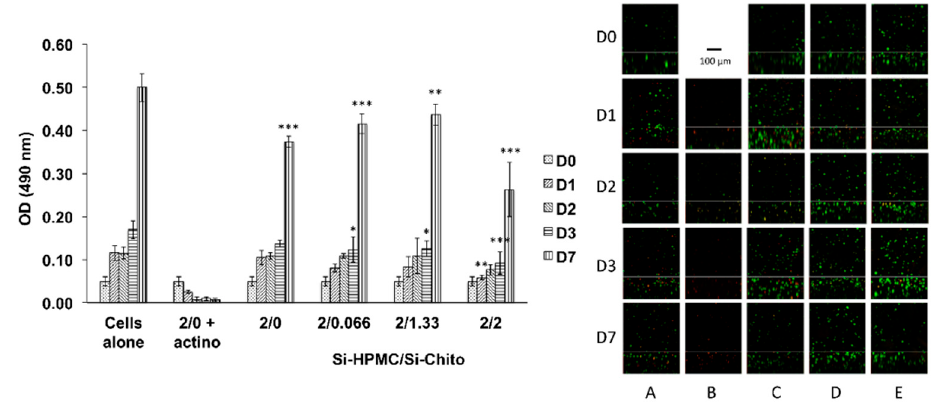
Figure 4. Left: graph representing SW1353 2D cell metabolism (cell growth) with an increasing Si-HPMC concentration over a period of time of 7 days. Right: confocal micrograph representing the 3D cell viability with an increasing Si-chito (Si-HPMC / Si-chito: A: 2% / 0%; B: 2% / 0% + actinomycin; C: 2% / 0.66%; D: 2% / 1.33 and E: 2% / 2%) concentration over a period of time of 7 days (D0, D1, D2, D3 and D7) using LIVE / DEAD staining kit labeling living cells in green and dead cells in red. Si-HPMC alone was used as positive control and actinomycin as control of cell death. Scale bar: 100 µm. * p < 0.05 compared to the cells alone condition ** p < 0.01 compared to the cells alone condition *** p < 0.001 compared to the cells alone condition